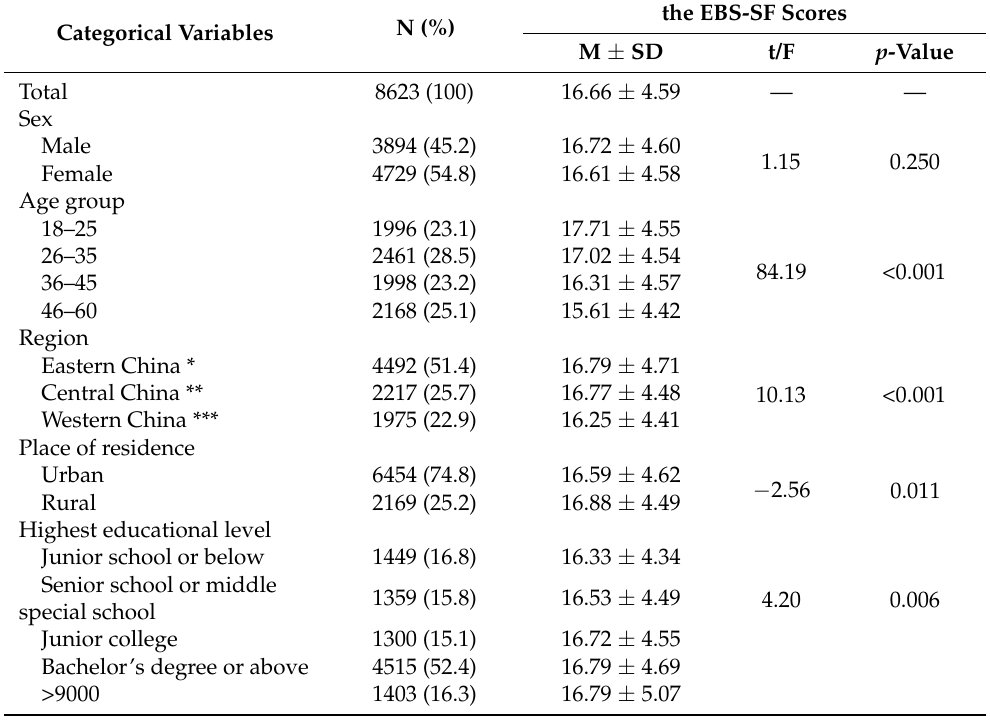
Table 1. The statistical description of categorical variables and the EBS-SF scores of study samples. Categorical